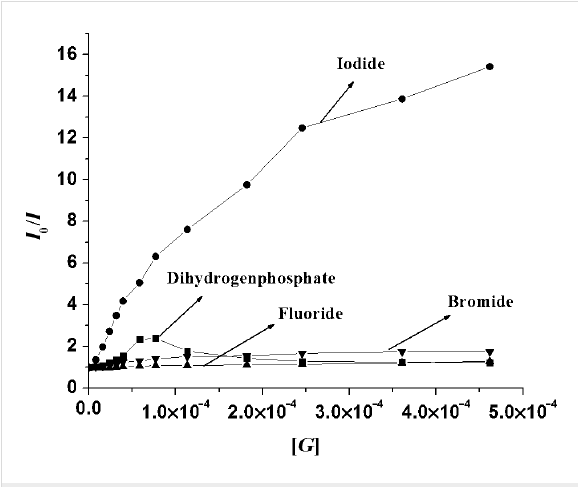
Figure 12: Stern–Volmer plots for 1 ( c = 5.78 × 10 − 5 M) with H 2 PO 4 − , F − , Br − and I − at 420 nm (up to the addition of 2 equiv of guest) in CHCl 3 containing 0.1% CH 3